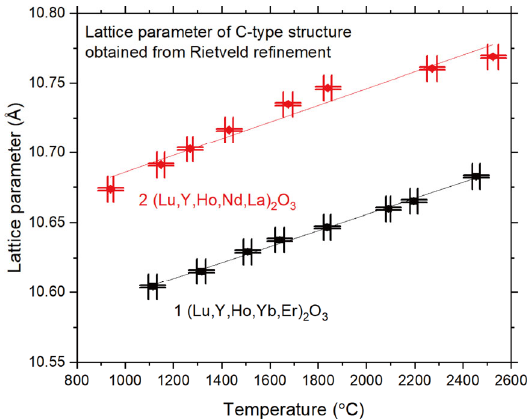
Fig. 4 Lattice parameters of the C-type structure were obtained via Rietveld structure refinement from neutron diffraction data collected for beads of compositions 1 and 2. In general, the bead of composition 2 (AIR = 0.938 Å) has larger lattice parameters than those of composition 1 (AIR = 0.875 Å) due to its larger AIR. Linear regression fits are shown for each